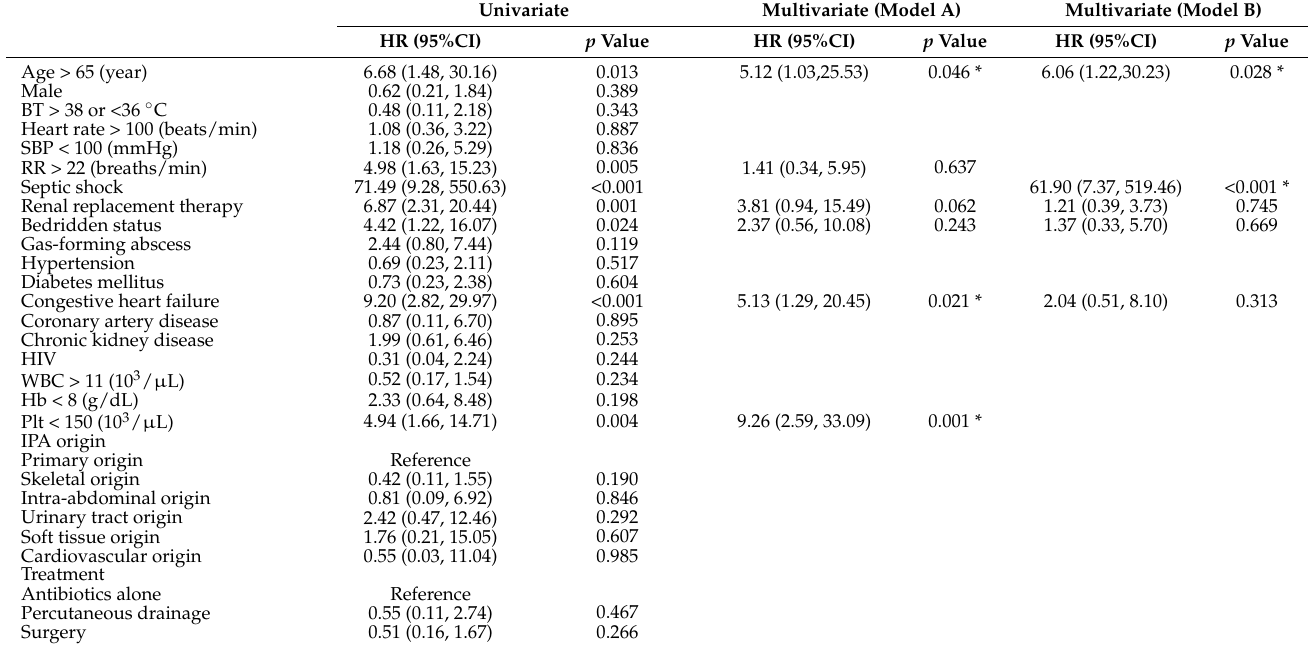
Table 5. Univariate and multivariate analyses of predictors of in-hospital mortality with Cox propor- tional hazards